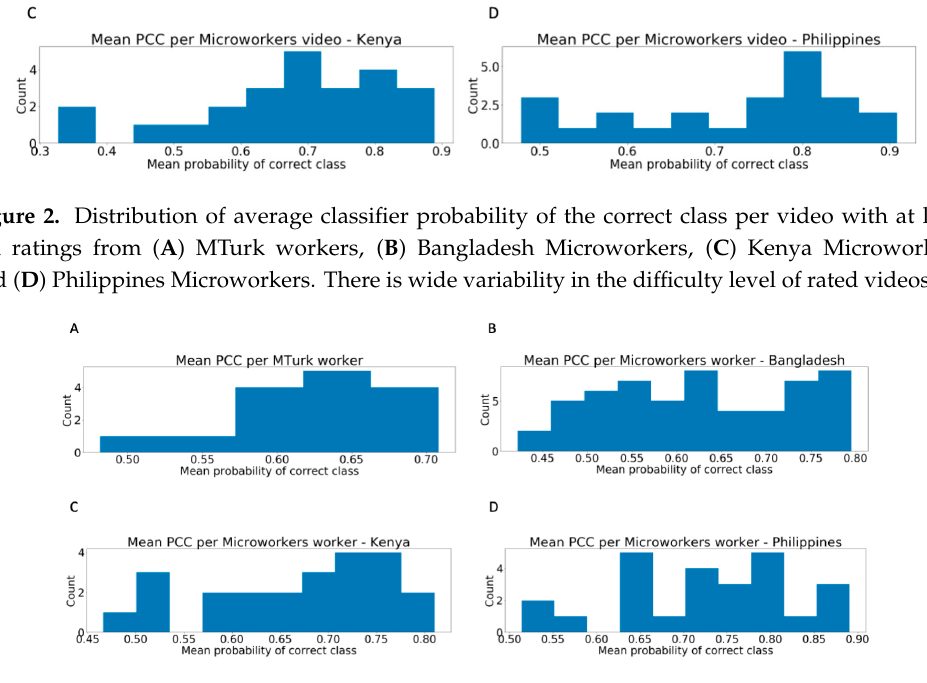
Figure 2. Distribution of average classifier probability of the correct class per video with at least ten ratings from ( A ) MTurk workers, ( B ) Bangladesh Microworkers, ( C ) Kenya Microworkers, and ( D ) Philippines Microworkers. There is wide variability in the difficulty level of rated videos.